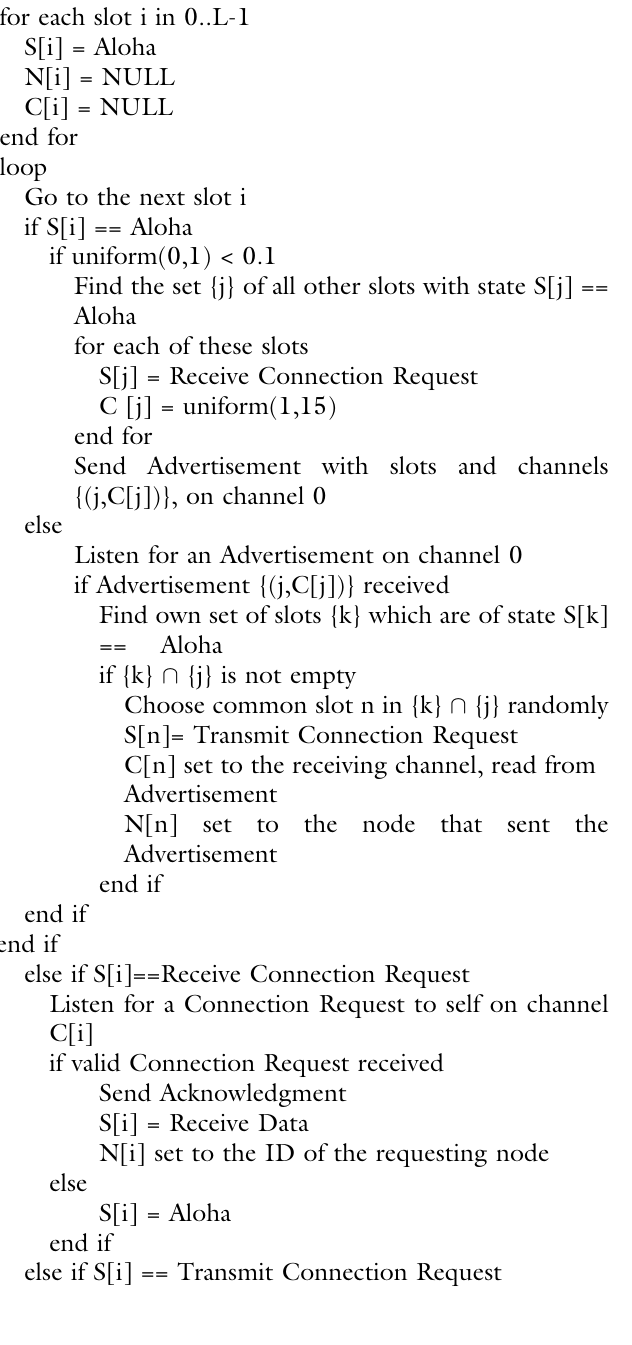
Algorithm 1: Aloha-Based Scheduling